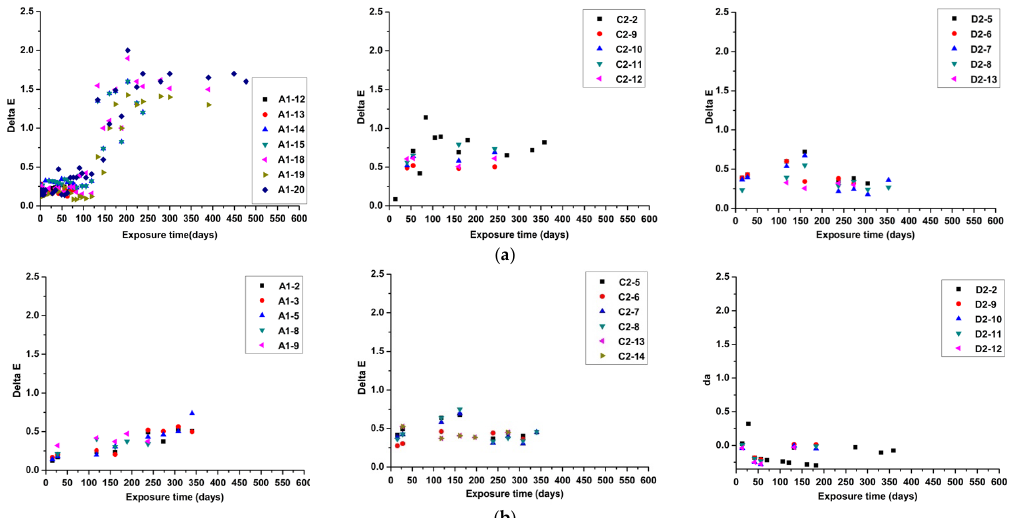
Figure 6. Evolution of total color change (Δ E ) of monolithic mirrors A1, C2, and D2 paint coatings during exposure time at ( a ) the seaside site and ( b ) desert site.